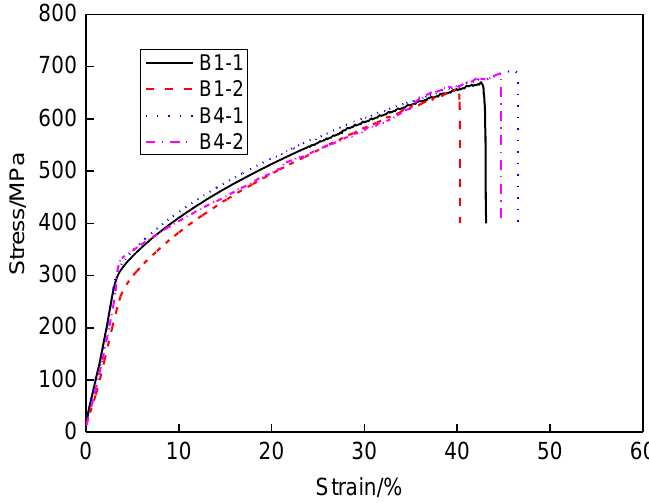
Table 3. The SSRT results of for different solutions and dimensions.